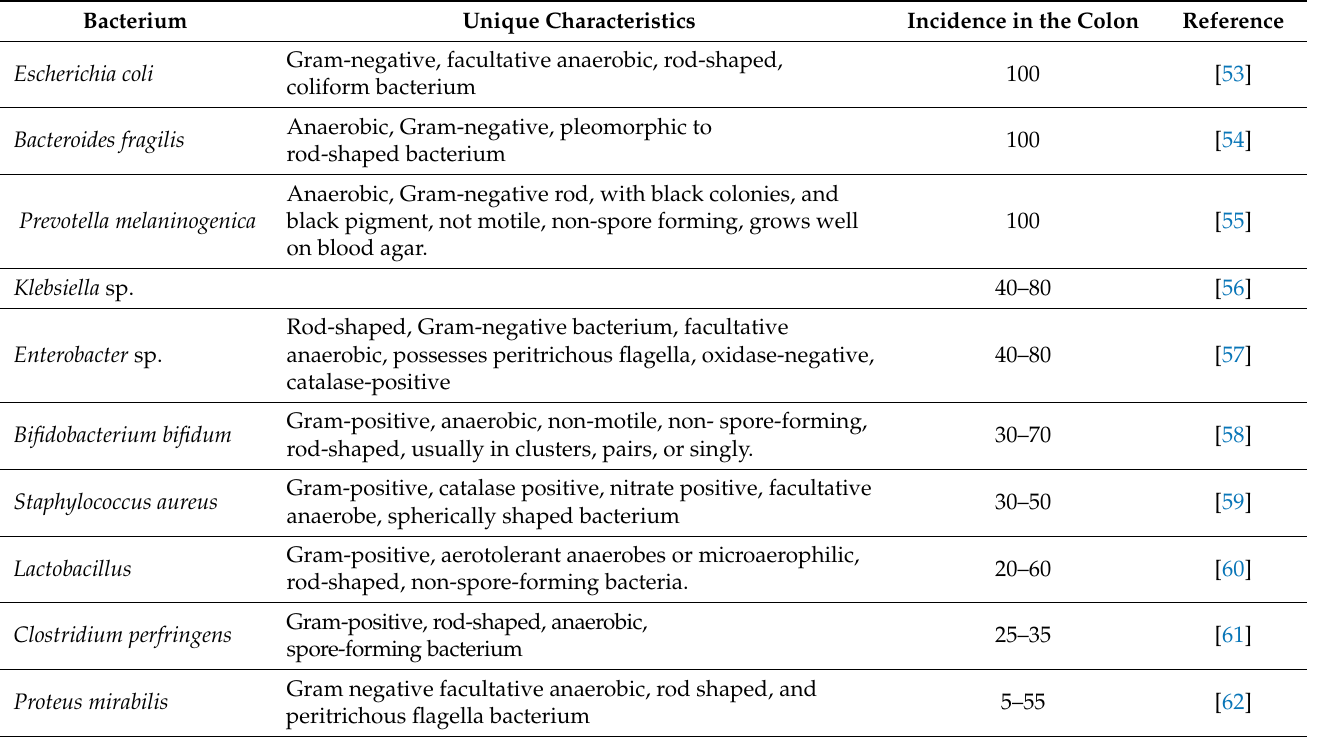
Table 1. Major Gut Microbiota found in the colon and their unique characteristics